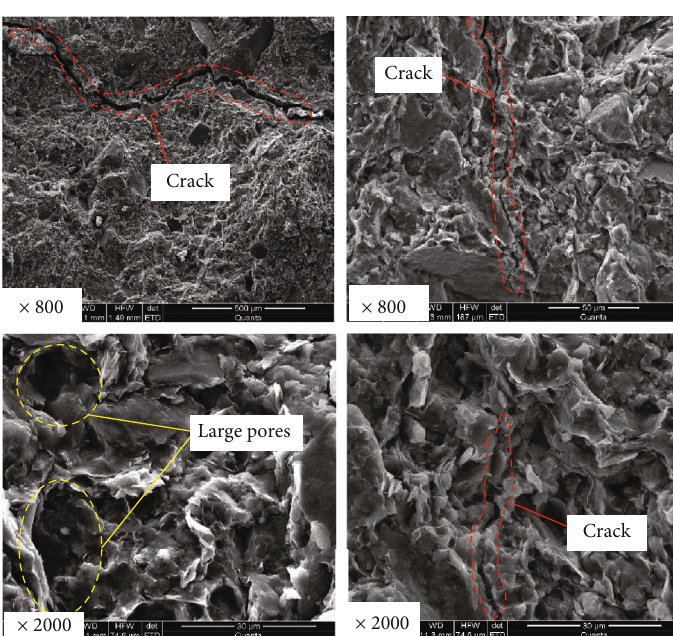
Figure 2: SEM results of